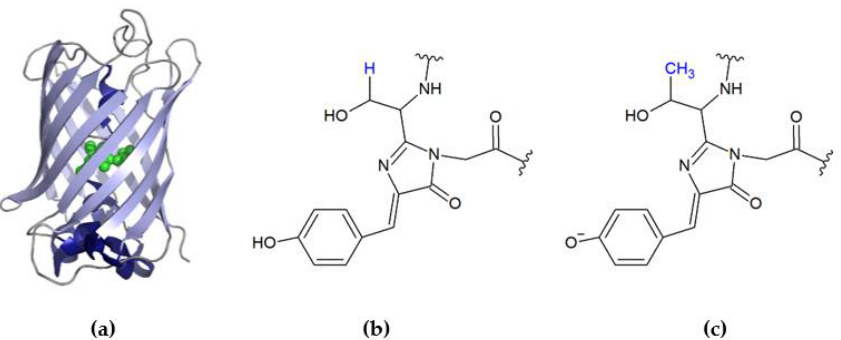
Figure 1. ( a ) The structure of EGFP (PDB ID 2Y0G [13]) with the highlighted location of the chromophore (in green). ( b ) The molecular structure of the wild type GFP chromophore (PDB ID 1W7S [12]) with Ser at 65 position. ( c ) The molecular structure of the EGFP chromophore with Thr at 65 position. The three-dimensional structure of EGFP and the molecular chemical structures of the chromophores were rendered using the public access software, Pymol v0.99 and ACD/ChemSketch, respectively.